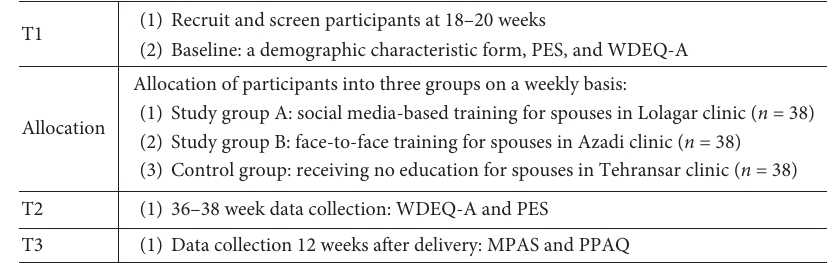
Figure 1: Key points for data